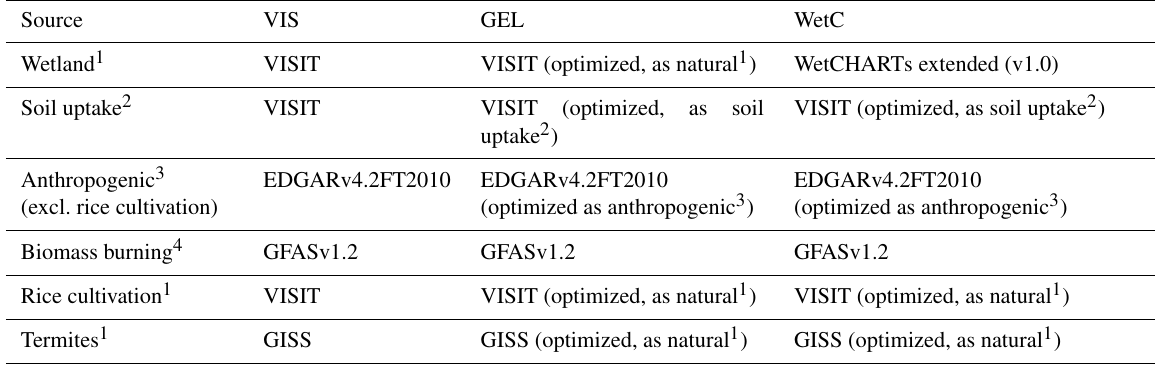
Table 2. Three cases of prior CH 4 fluxes. Source VIS GEL WetC Wetland 1 VISIT VISIT (optimized, as natural 1 ) WetCHARTs extended (v1.0) VISIT VISIT (optimized, as soil VISIT (optimized, as soil uptake 2 ) uptake 2 ) Anthropogenic 3 EDGARv4.2FT2010 EDGARv4.2FT2010 EDGARv4.2FT2010 (optimized as anthropogenic 3 ) (optimized as anthropogenic 3 ) GFASv1.2 GFASv1.2